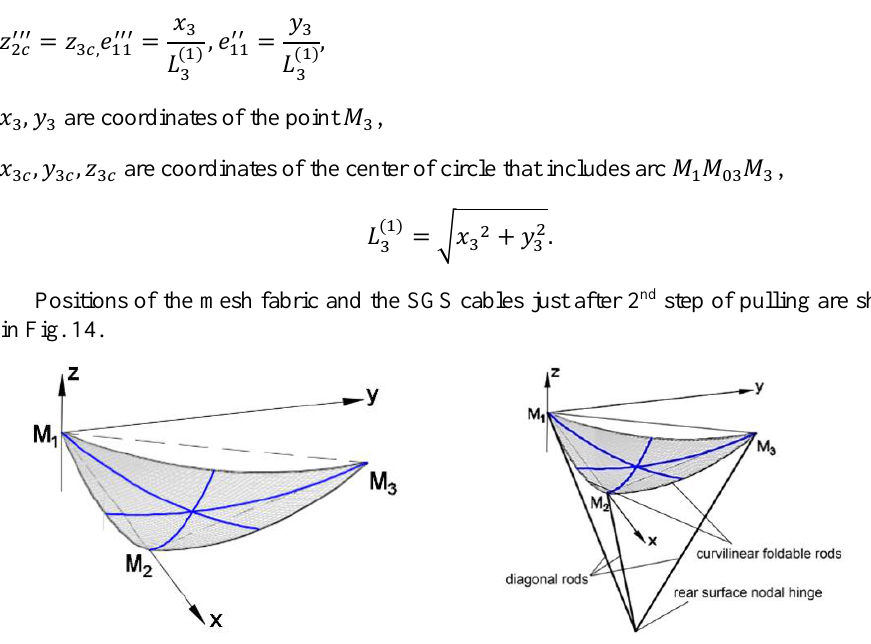
Fig. 14. Positions of the mesh fabric and the SGS cables just after 2 nd step of